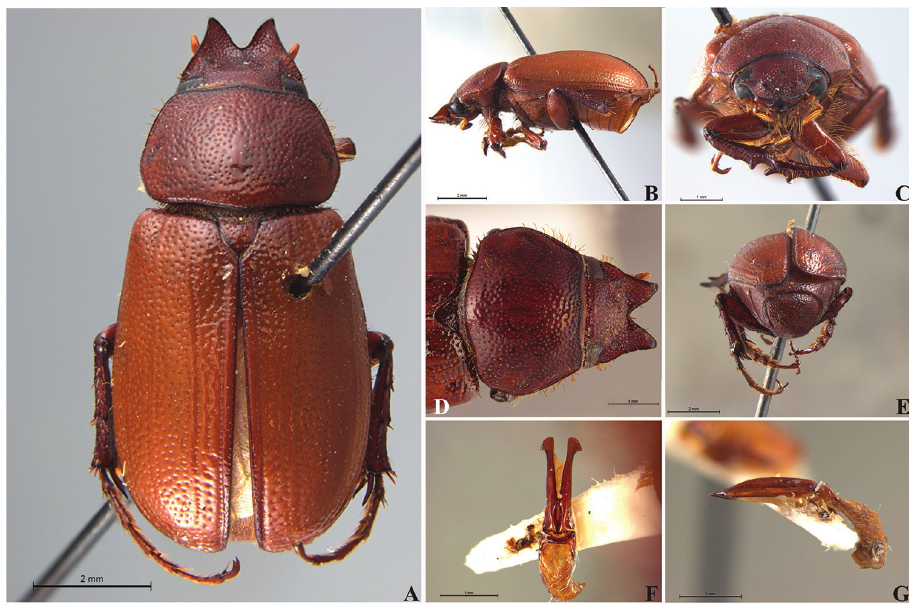
Figure 62. Liogenys diodon Burmeister. A Dorsal view B Lateral view C Frontal view D Clypeus and pronotum E Pygidium F Parameres, dorsal view G Parameres, lateral